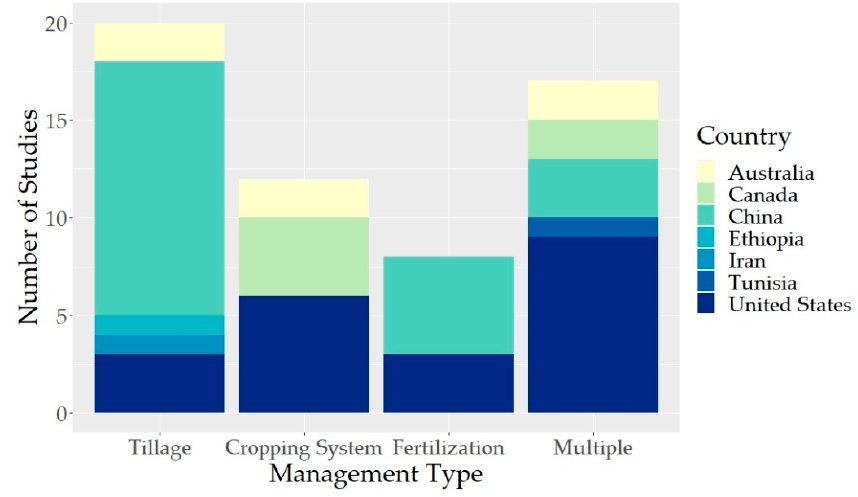
Figure 1. Number of reviewed studies by management type and country.